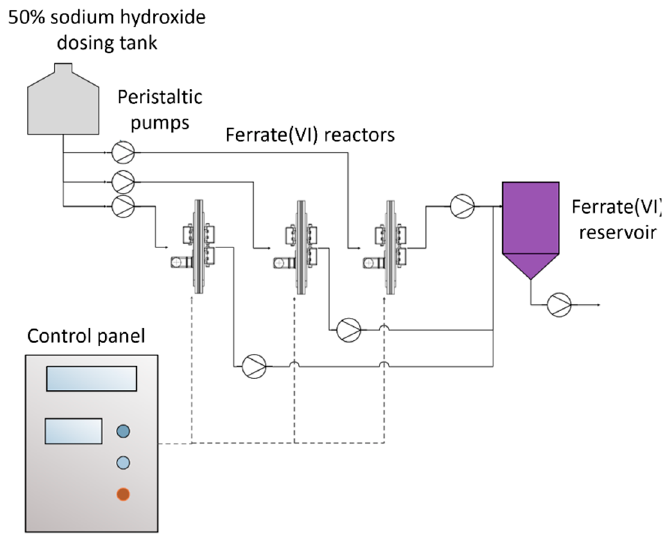
Figure 1. Ferrate(VI) production system.